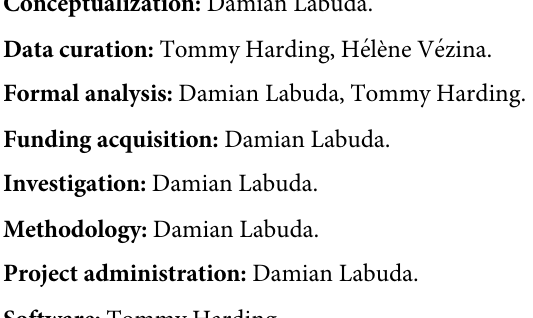
S10 Fig. Proportion of different categories of parents with no married children, i.e., of zero EFS. Percentages of immigrant men (dark grey line), immigrant women (yellow line), QB men (cyan line), QB women (green line), all men (blue line), and all women (red line) without married children as a function of their marriage year by 5-year intervals. The light grey line indicates an estimate of the infertility rate (15%;